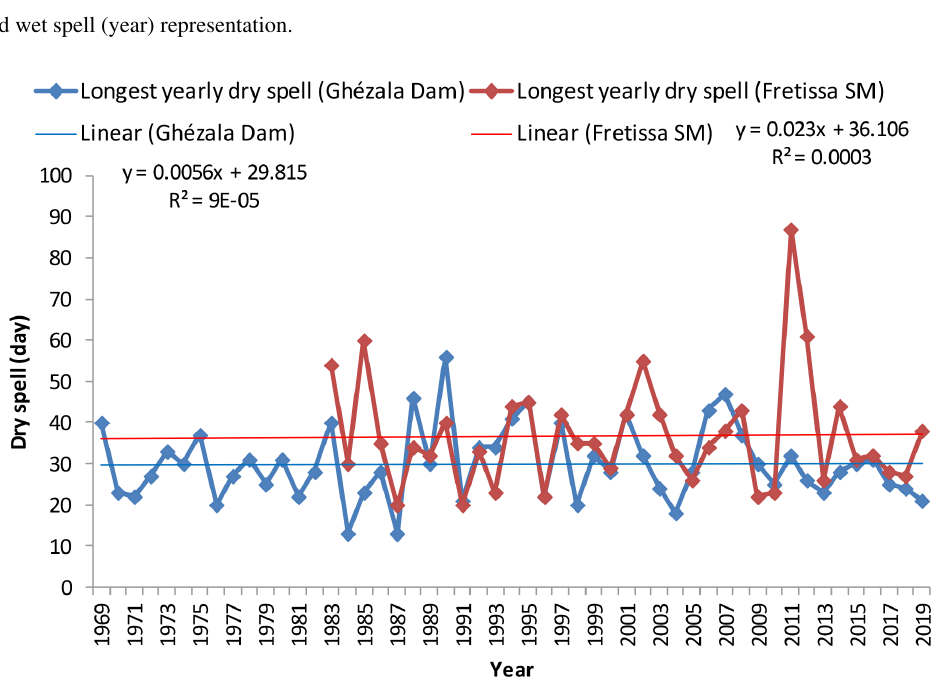
Figure 3. Maximum yearly dry event in days for Ghézala Dam and Fretissa SM rain